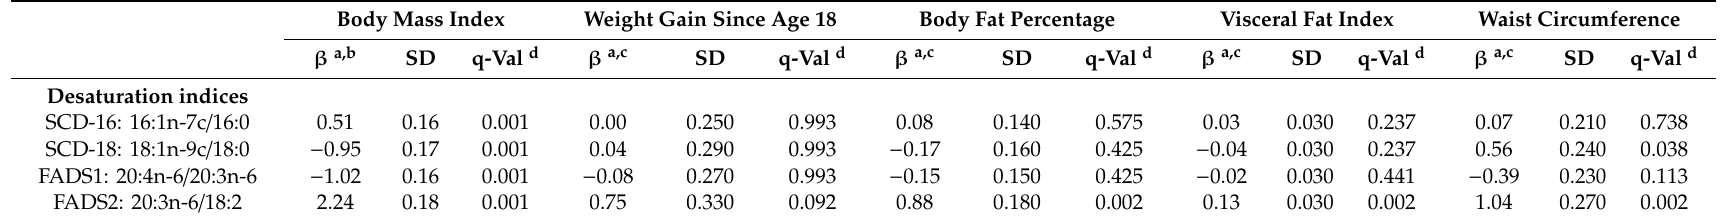
Table 5. Association between desaturation indices and anthropometric